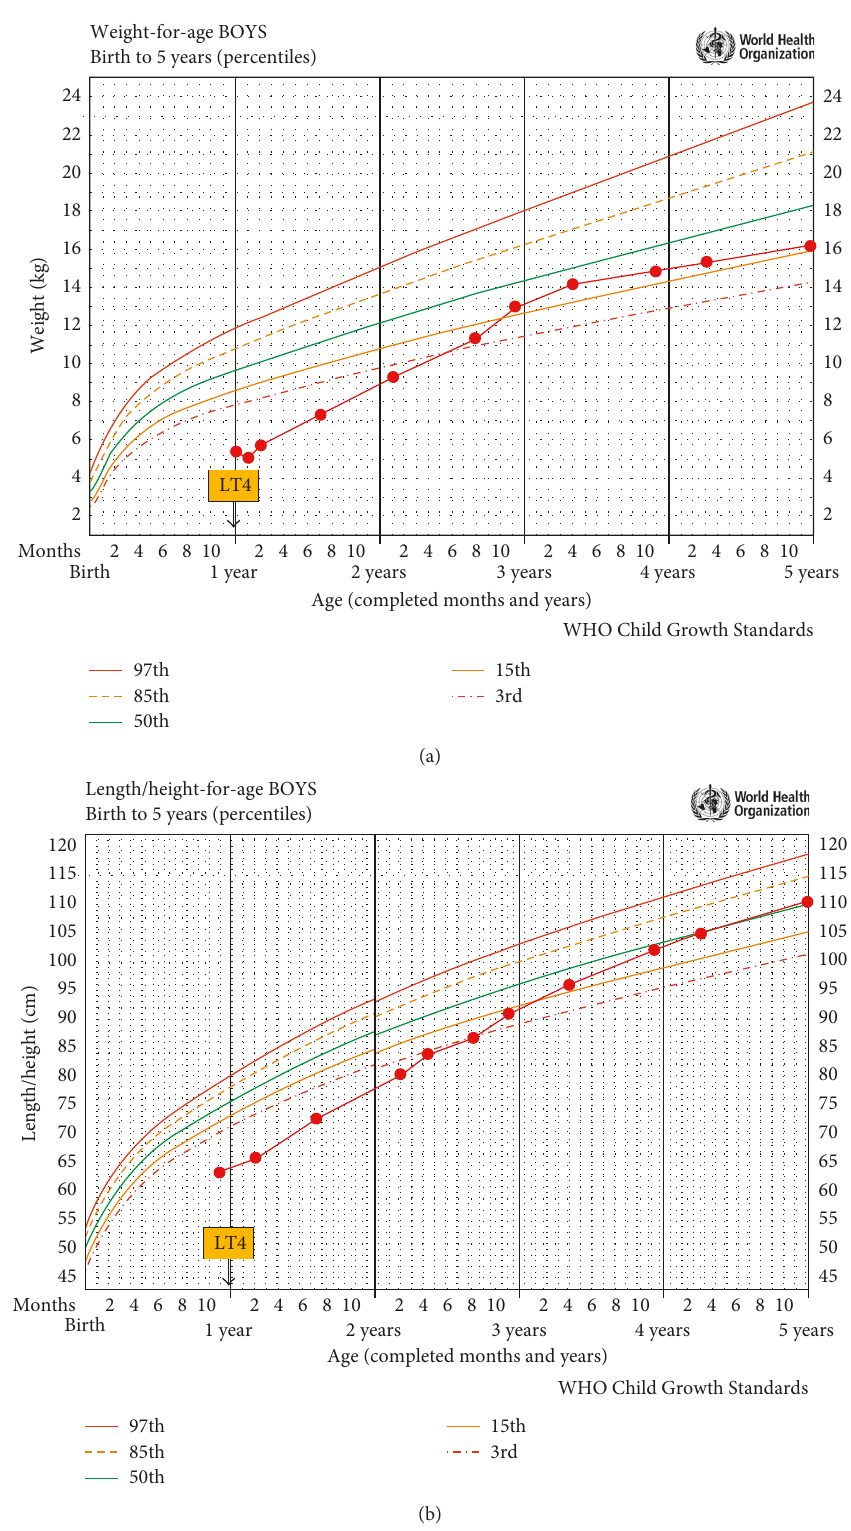
Figure 2: Weight-for-age (a) and length/height-for-age (b) growth reference charts, according to the World Health Organization (WHO 2006), showing a rapid catchup after levothyroxine sodium replacement therapy. LT 4 : levothyroxine